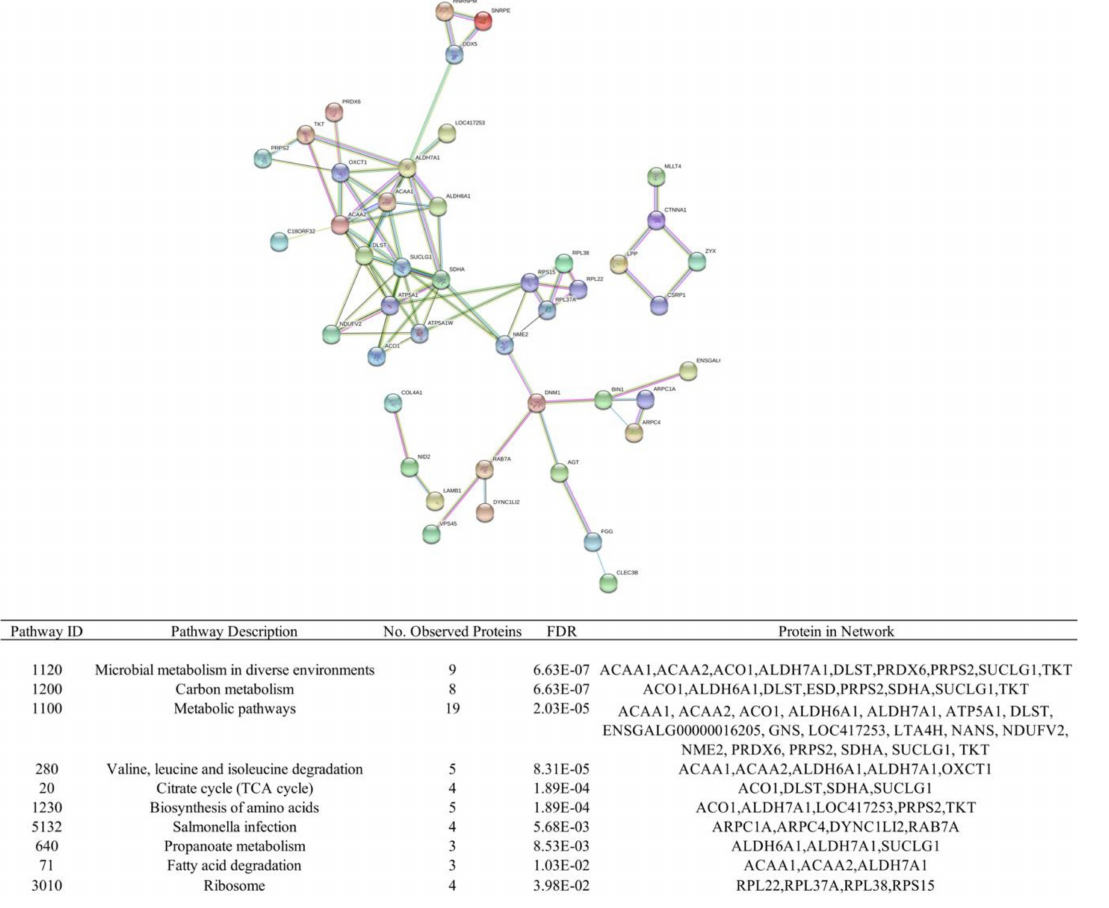
Figure 2. STRING network analysis on DAPs between treated and non-treated Leghorns at 6 dpi. Nodes depict protein-protein interactions. Figure table lists the significantly enriched pathways and their corresponding differentially abundant protein within these